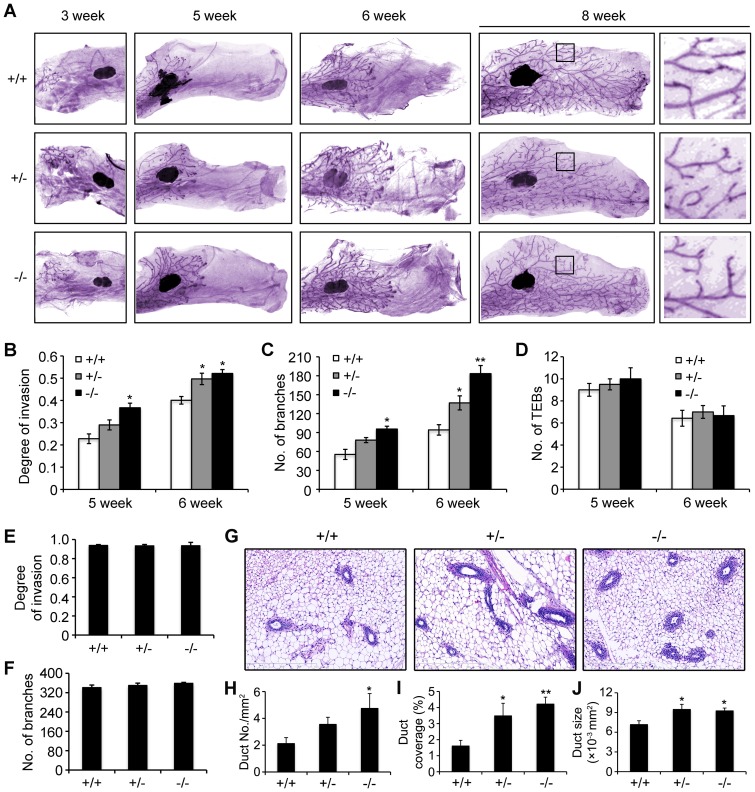
Deletion of Atbf1 promotes ductal elongation and bifurcation in pubertal mammary gland.(A) Hematoxylin-stained whole-mount images of the fourth abdominal mammary glands from mice at indicated ages. Panels at far right are higher magnification images of indicted areas from 8-week old mammary glands. Three to five mice were used for each genotype. (B–F) Determination of degree of ductal invasion and the numbers of branches and TEBs in mammary glands of mice with indicated genotypes and ages of 5 or 6 weeks (B–D) or 8 weeks (E, F). Degree of ductal invasion was determined by dividing the duct length by the mammary gland length from mid-point of lymph node; and the numbers of total branches and TEBs were determined in whole-mount images by the ImageJ program. (G–J) Comparisons of the numbers and areas of ducts among different genotypes. Shown are representative images from hematoxylin and eosin (HE)-stained tissue sections (Magnification: 100×) from mammary glands at the age of 6-week old, the average number of ducts per mm2 (H), ductal area to gland area ratio (ductal coverage) (I), and the average cross-section size per duct (10−3 mm2) (all ducts were measured for each mouse) (J). HE-stained tissue sections (G) were used for these analyses. Each bar is the average from three mice for each genotype. * and ** indicate P<0.05 and P<0.01 respectively. For panels H–I, one-way ANOVA was used for statistical analysis, while univariate analysis (sum of squares: type I) was used for panel J.